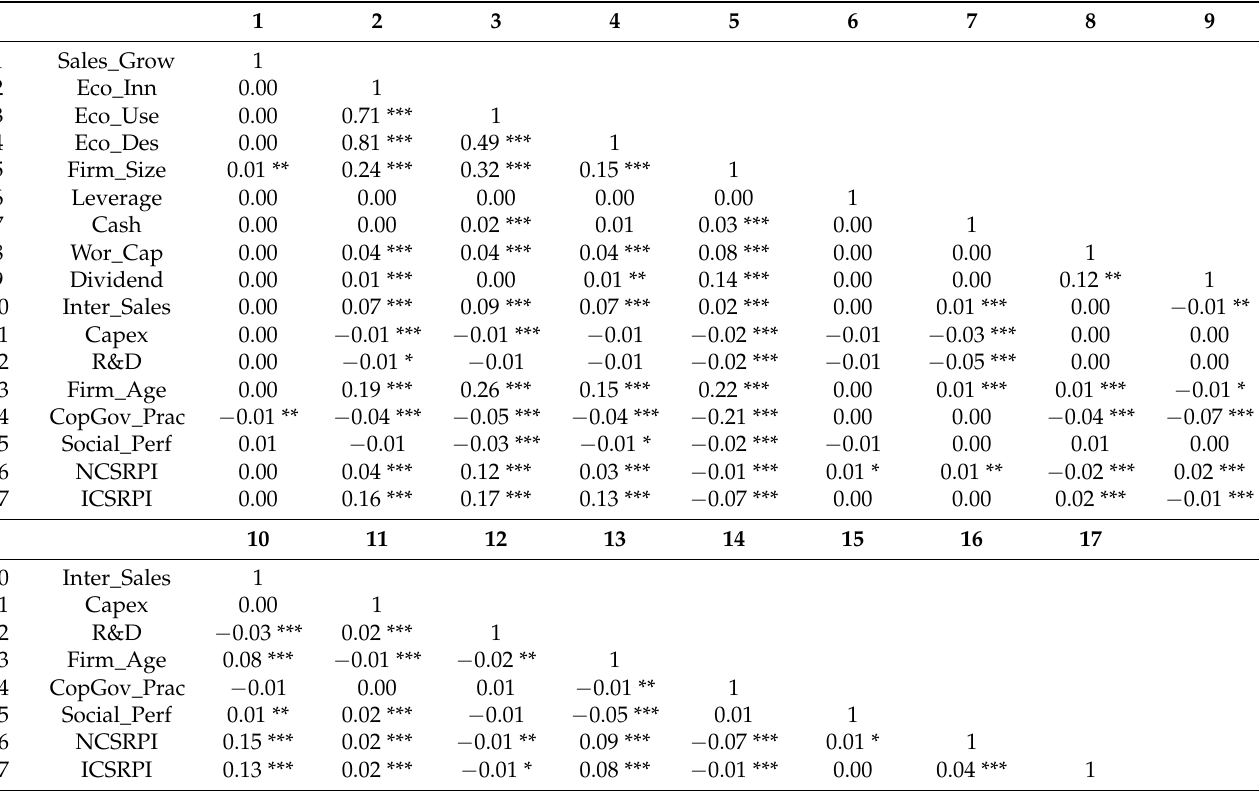
Table 3. Bivariate correlations (*** p < 0.01, ** p < 0.05, * p <